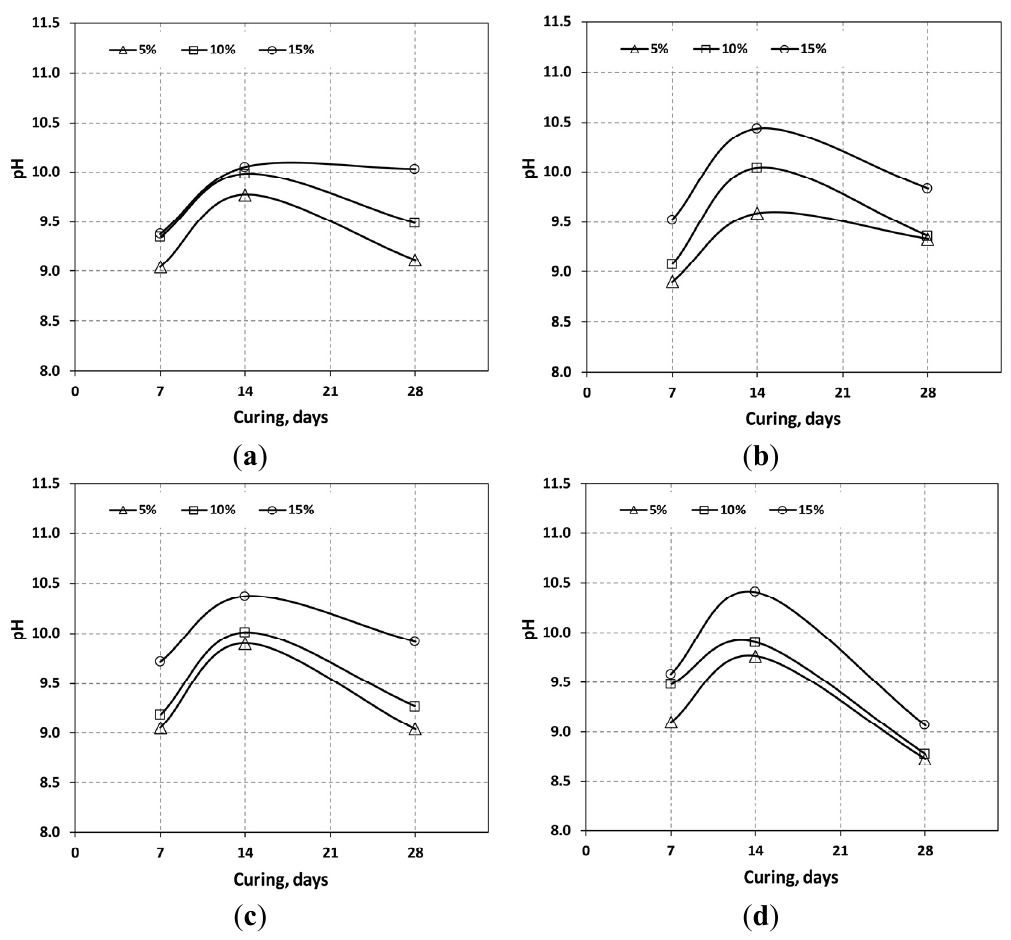
Figure 6. The pH values of mixtures with the curing time ( a ) OPC; ( b ) OPC + OSP; ( c ) OPC + SMS; ( d ) OPC +